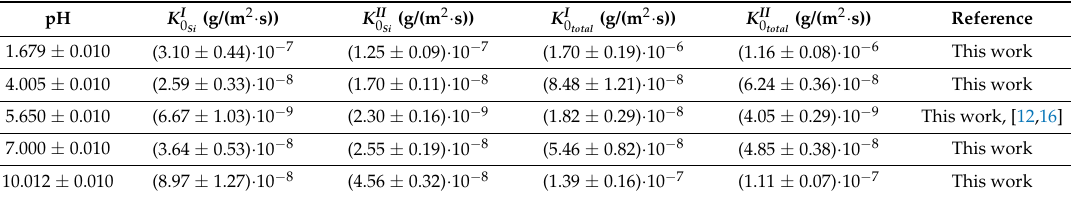
Table 1. The glass dissolution rate constants obtained via the regression of the experimental data of the R-glass fibre bundles using the Dissolving Cylinder Zero-Order Kinetic (DCZOK) model for Si and the total mass loss at 60 ◦ C and various pH levels. K I for Phase I and II for Si and total glass dissolution, as indicated by